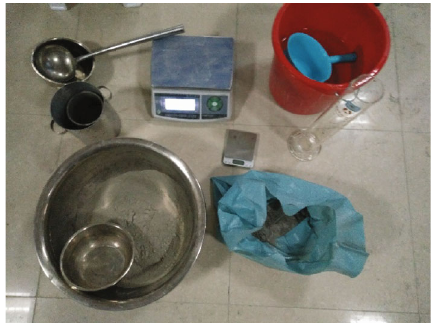
Figure 3: Filling ratio experiment.